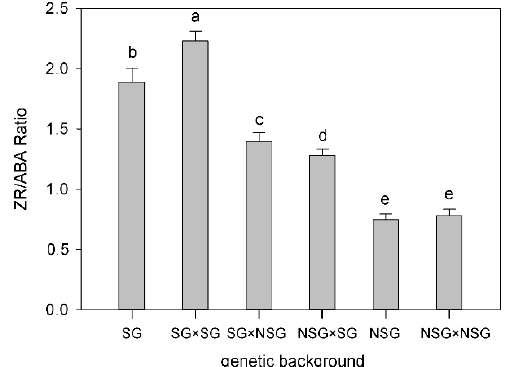
Figure 7. The ratio of zeatin riboside (ZR)/abscisic acid (ABA) in ear leaves from different maize genetic backgrounds from silking to maturity. Values are means of the four stages (silking, filling, milky, and maturity). The different letters indicate significance at the p < 0.05 level. SG is for CZ01 and Q319, NSG is for BM and B73, SG × NSG is for Q319 × BM, NSG × NSG is for BM × B73, SG × SG is for Q319 × CZ01, and NSG × SG is for BM × Q319.